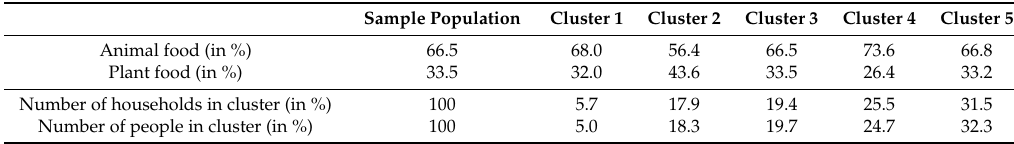
Table 10. Cluster description: animal vs. plant